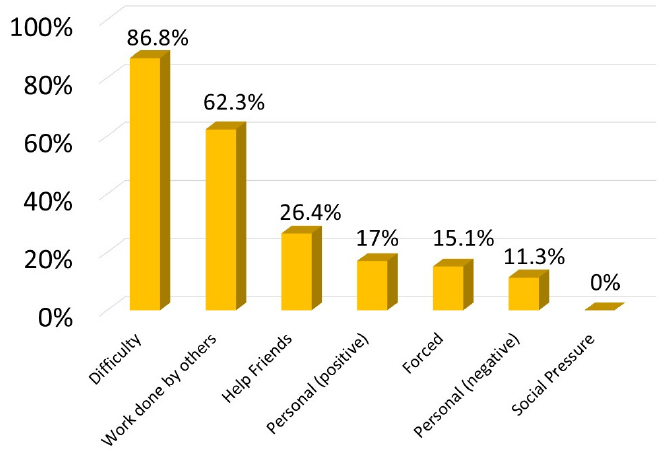
Figure 2. Percentage of students who considered relevant the 7 factors not related to user types.